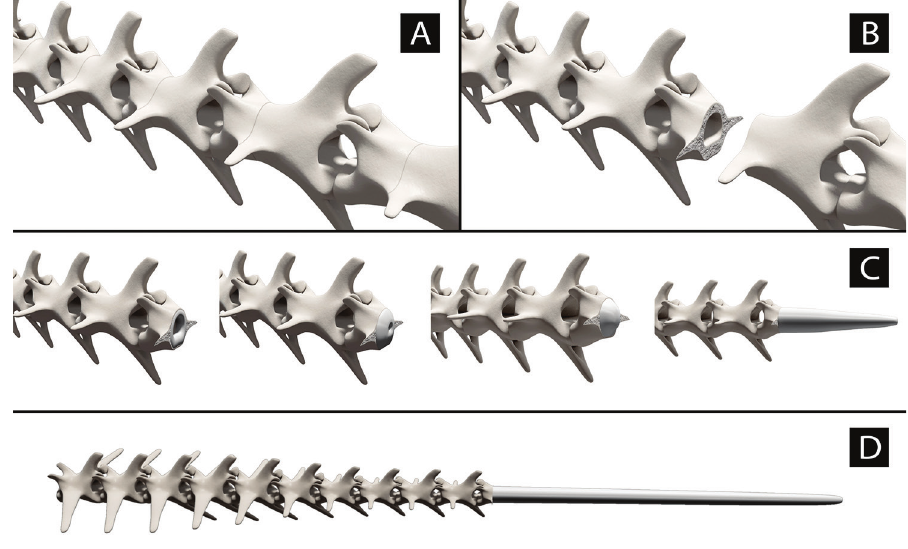
Figure 3 - Original illustration rendering, showing the autotomy’s osteological peculiarities of Tropidurus itambere . A: Intravertebral fracture planes; B: The occurrence of autotomy in a vertebrae; C: Four stages of cartilage regeneration; and D: Fully regenerated tail with cartilaginous stick replacing the